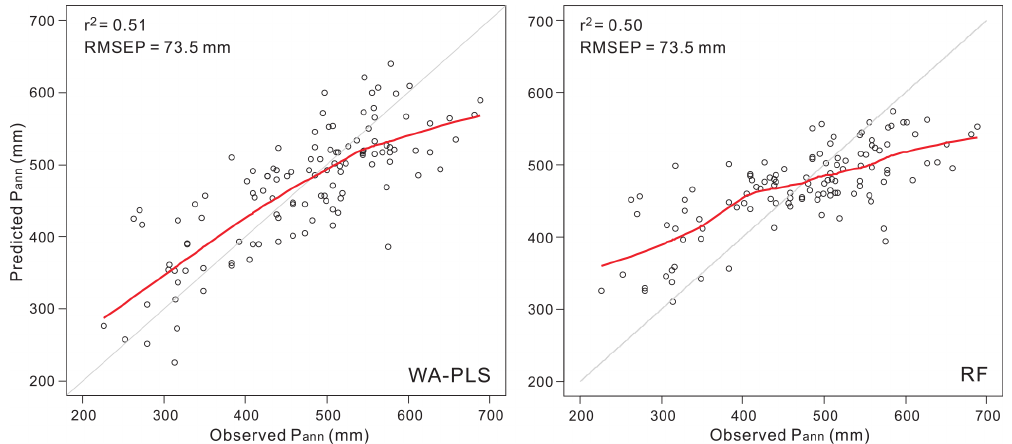
Figure 5. Scatter plots of observed annual precipitation ( P ann ) vs. predicted P ann by weighted-averaging partial least squares regression (WA-PLS) and random forest algorithm